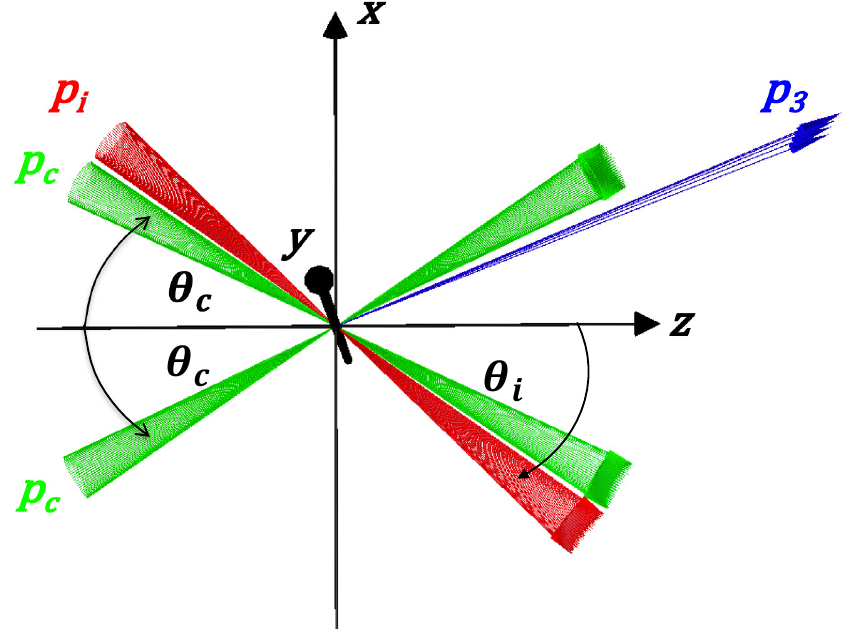
Figure 1. Schematic view of a three-beam stimulated photon